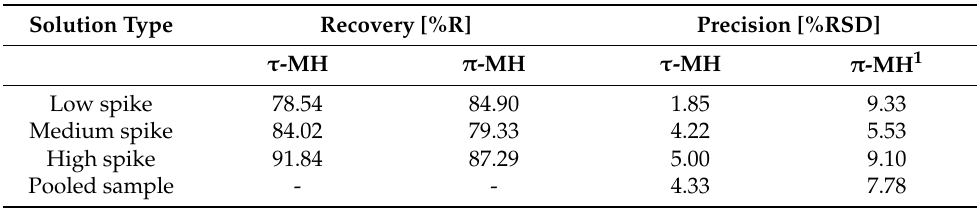
Table 1. Recovery values and extraction repeatability values ( n = 3) for τ - and π -MH. Recoveries are within the 70–120% range, which is considered by the authors acceptable for the purpose of this study. Precision in all cases is below 10%.